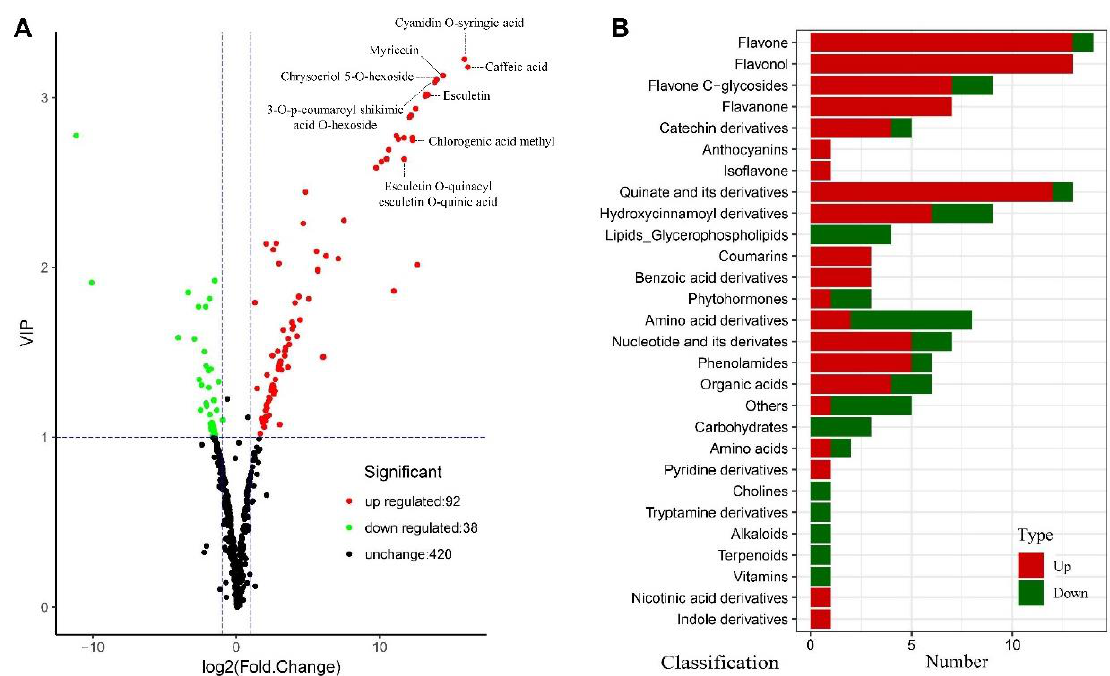
Figure 2. Volcano plot and classification of differential metabolites in leaves of EsMYB90 transgenic tobacco relative to wild type. ( A ) The volcano plot exhibits metabolites detected in metabolome. The abscissa represents the logarithm of the quantitative difference multiples of metabolites (log 2 FC); the ordinate represents the variable importance in project (VIP) value. Green dots represent the down-regulated differential metabolites; red dots represent the up-regulated differential metabolites; black dots represent the metabolites that were detected with no significant difference. ( B ) Classification of the differential metabolites. The ordinate represents the name of the metabolites and the abscissa represents the number of metabolites. The red represents up-regulated metabolites and the green represents down-regulated metabolites.